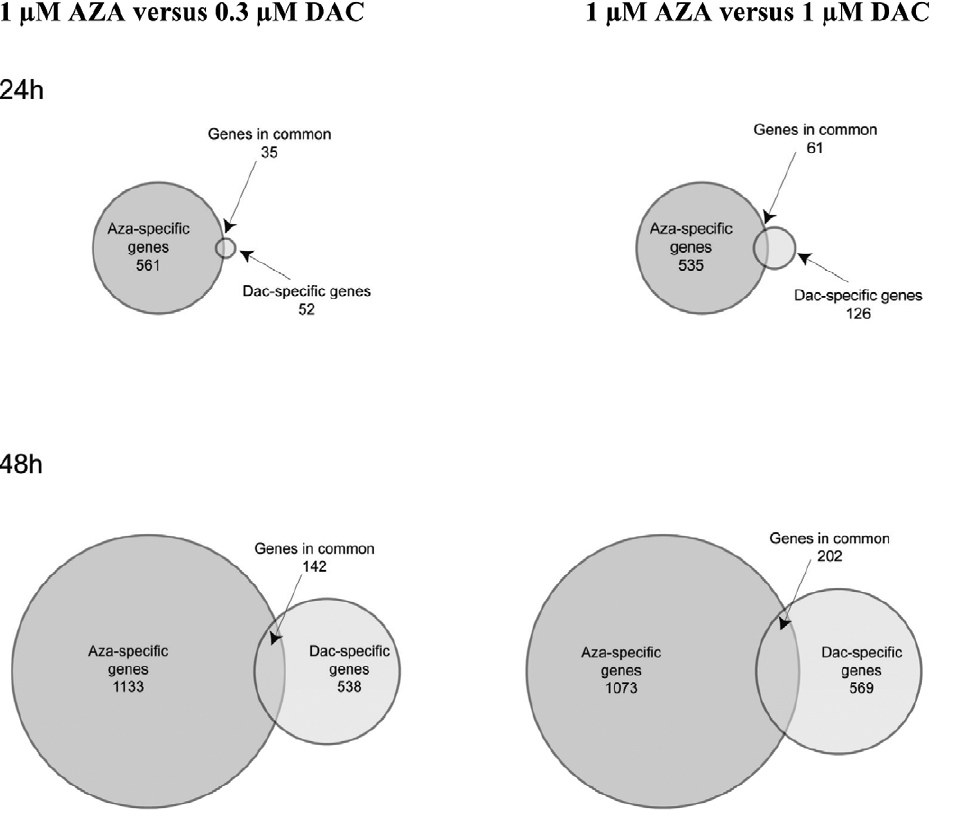
Figure 7. AZA and DAC regulate different genes in KG-1a cells. Venn diagrams reveal the number of genes that are distinctly and commonly regulated by daily treatment with AZA (1 m M) or DAC (0.3 m M or 1 m M) in KG-1a cells at 24 and 48 hours. AZA = azacitidine; DAC = decitabine.